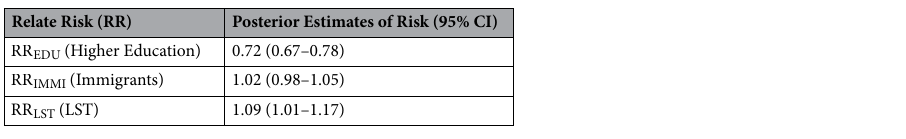
Table 4. Estimated relative risks [ exp (β k ) ] and 95%